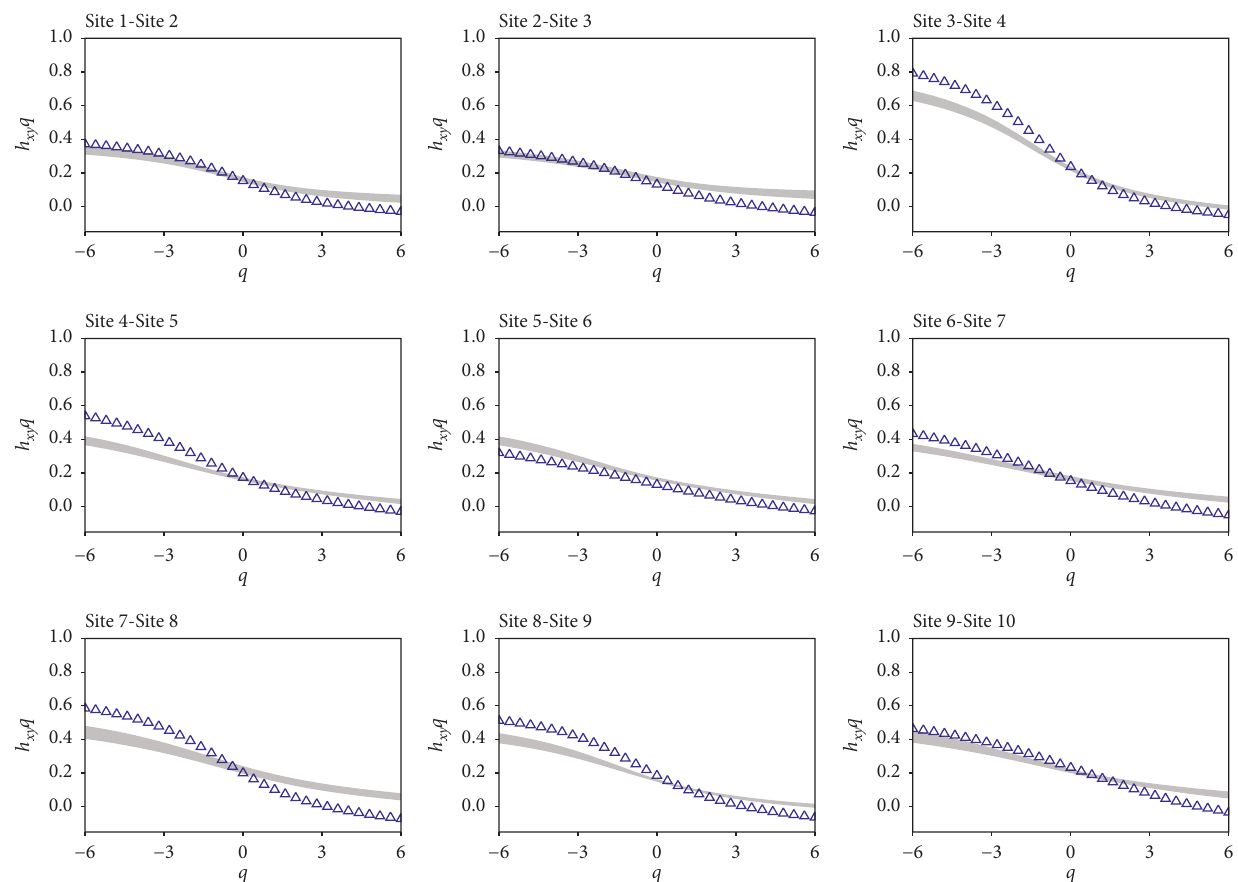
Figure 6: Testing via pair of surrogate series ( X preprocessed daily average river levels at adjacent sites. The shadow area indicates acceptance region of h XY ( q ) at 5% significance level estimated from 1000 pairs of surrogate series for the null hypothesis H